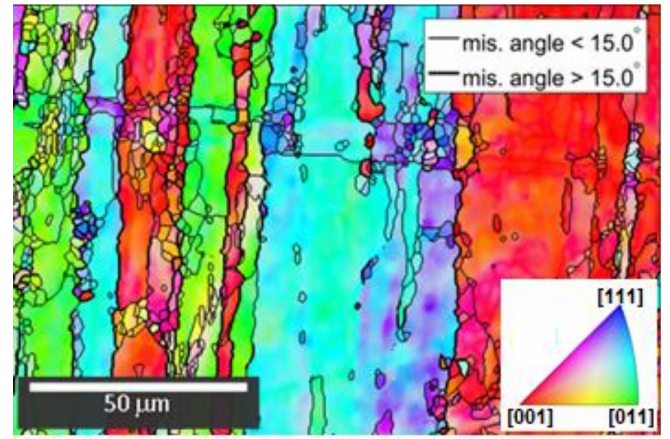
Figure 1. EBSD orientation map of the alloy after solution heat